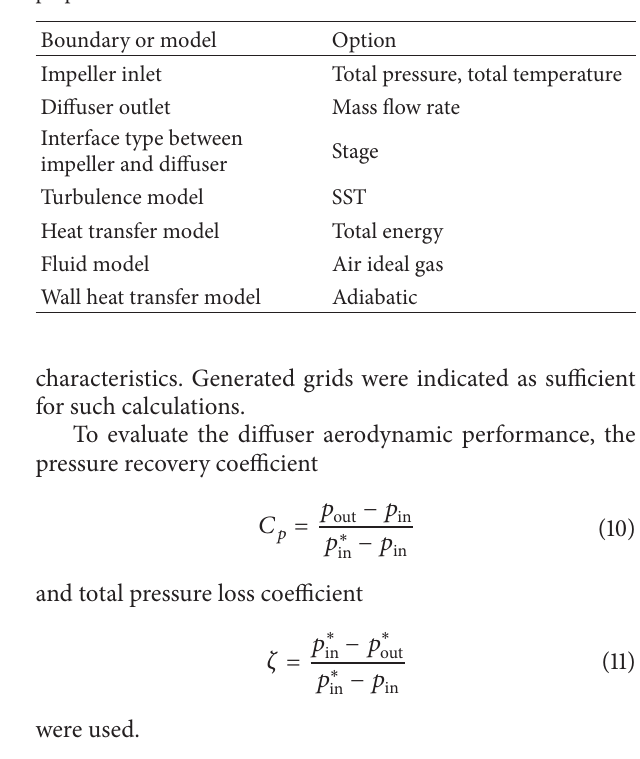
Table 2: Boundary conditions and models, specified in ANSYS CFX